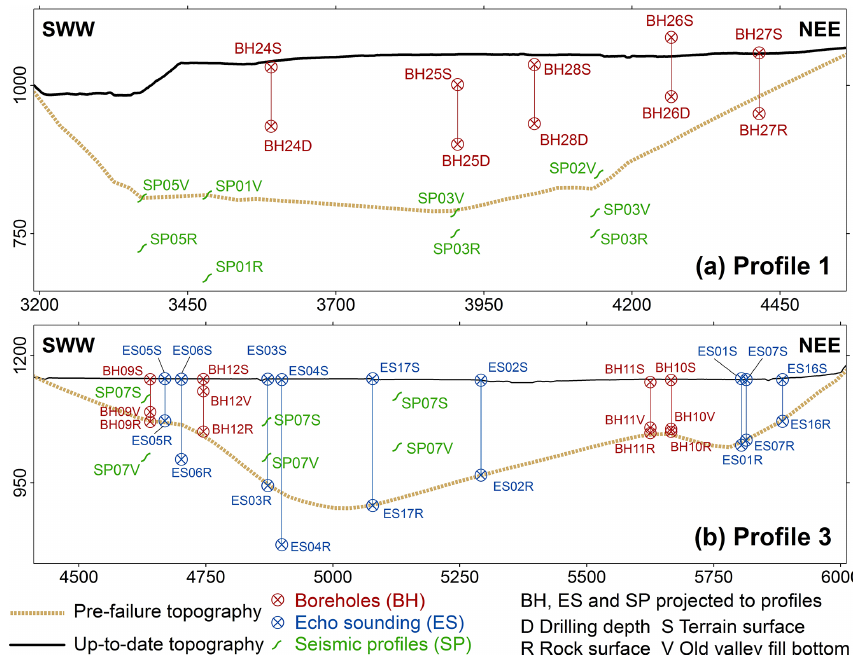
Figure 4. Profiles through the valley bottom in the Köfels rockslide area (see Figs. 2 and 3). (a) Profile 1 in the north of the Köfels site in the basin of Umhausen. (b) Profile 3 in the south of the Köfels site in the basin of Längenfeld. Note that the point data and seismic profiles (see Fig. 3) are projected to the profile planes and therefore do not necessarily correspond to the topographic surfaces